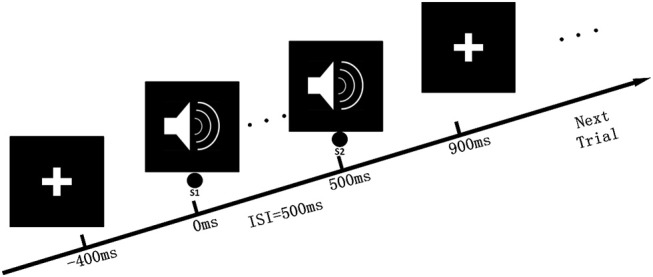
Auditory paired-stimulus paradigm. In the experimental procedure, the subject remained quiet and sat in a chair, facing the “cross” symbol on the front screen, and received paired-clicks through the ears. The time interval between the two stimuli was 500 ms, and 60 repetitions were conducted. Each test interval was 10 s.